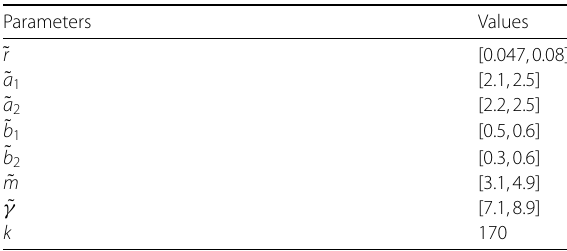
Table 5 The values of different parameters used to simulate the model system in Case-III Parameters